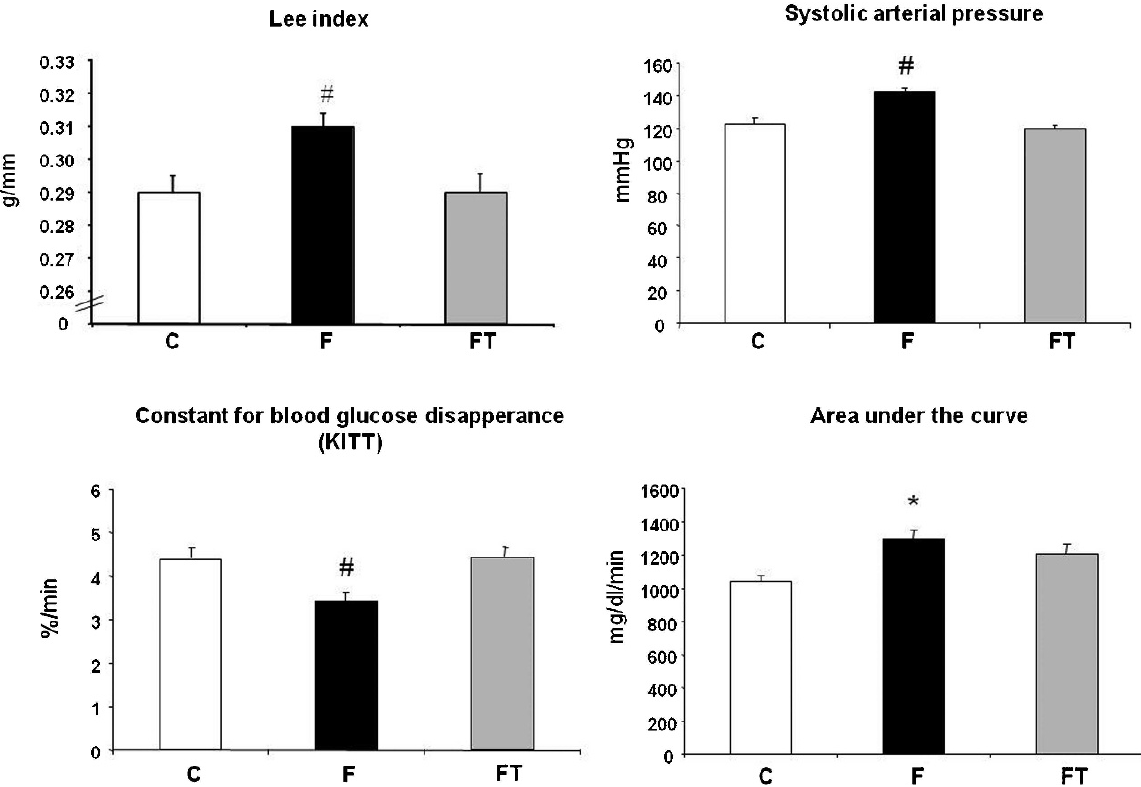
Figure 1 - Lee Index, systolic arterial pressure, the rate constant for blood glucose disappearance and area under the curve in control (C) high fructose-fed (F) and trained high fructose-fed (FT) groups. One-way ANOVA, * p , 0.05 vs. C and # p , 0.05 vs . C and